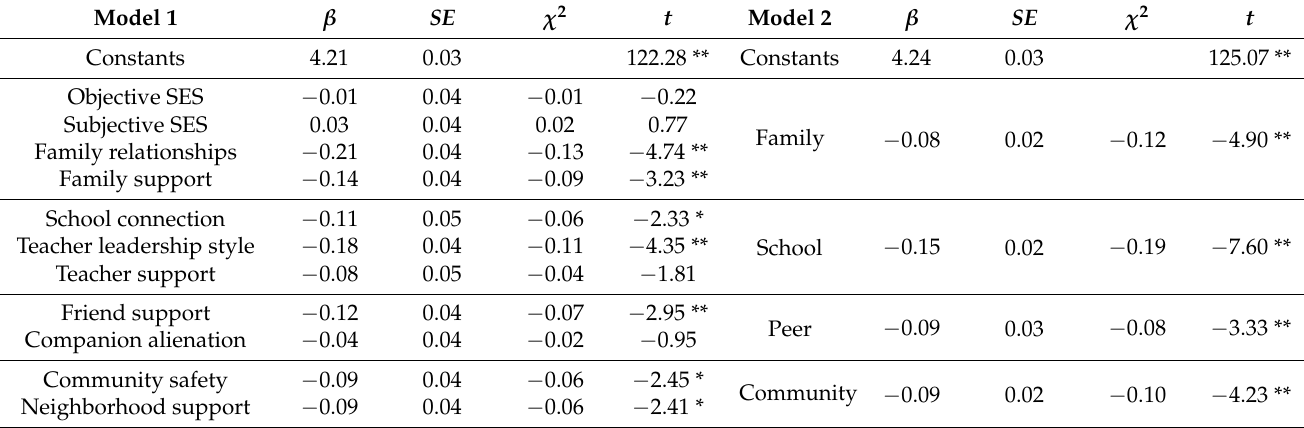
Table 3. Influence of Ecological Risks and Risk Fields on Social